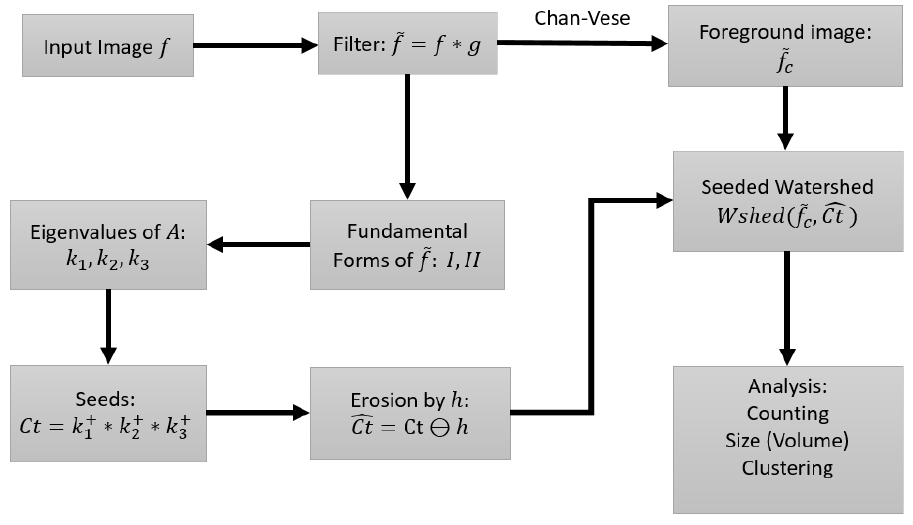
Figure 5. Flow of the processing steps in the proposed method.